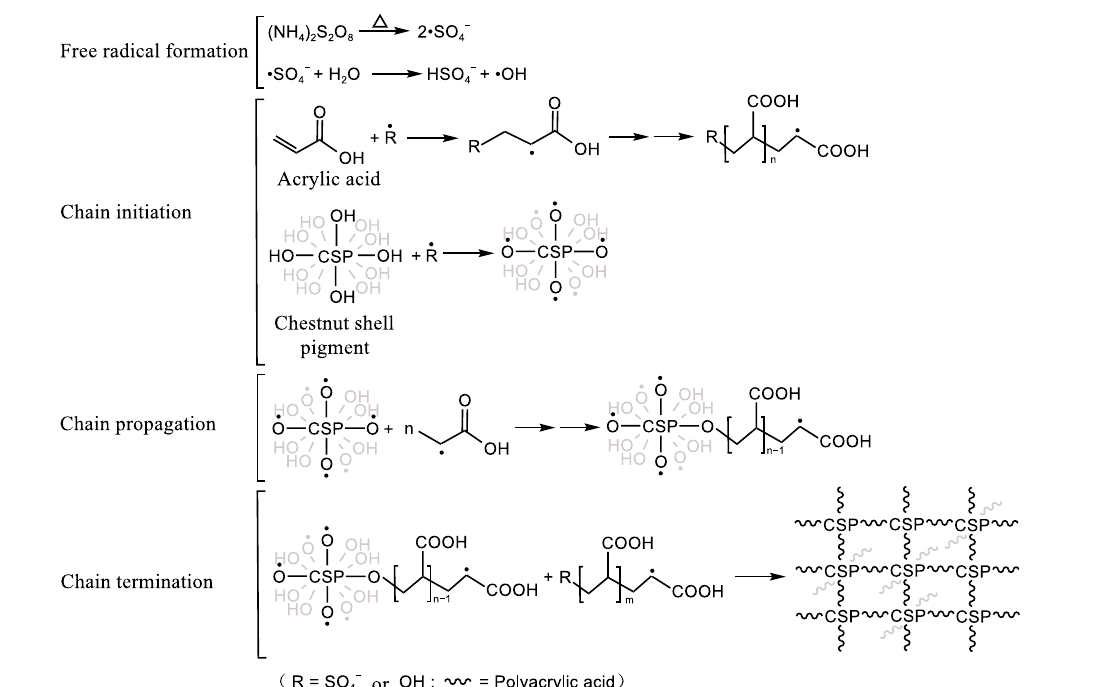
Scheme 1. Proposed reaction for synthesis of hydrogel crosslinked with chestnut shell pigment.